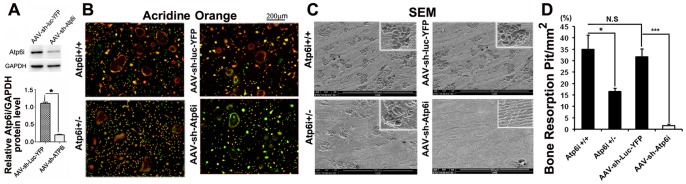
Both knockdown and haploinsufficiency of Atp6i impaired osteoclast-mediated extracellular acidification and bone resorption in vitro.(A) Western blot of Atp6i expression in mouse bone marrow (MBM) stimulated with M-CSF/RANKL for 1 day and transduced with AAV-sh-luc-YFP or AAV-sh-Atp6 and cultured for an additional 4 days. Quantification of western blot analysis demonstrates that AAV-sh-Atp6i treated osteoclasts have significantly reduced expression of Atp6i as compared to the AAV-sh-luc-YFP treatment group. (B) Acridine orange staining of osteoclasts including cells without fusion (<3 nuclei). Osteoclasts from Atp6i+/− mice show weak extracellular acidification (weak orange coloration) compared to osteoclasts from Atp6i+/+ mice. Osteoclasts transduced with AAV-sh-Atp6i have even less extracellular acidification (green coloration) compared to osteoclasts transduced with AAV-sh-luc-YFP. (C) Bone resorption pits were visualized by scanning electron microscopy (SEM). AAV-sh-Atp6i treatment and Atp6i knockdown greatly reduced the functions of osteoclasts. (D) Quantification of SEM bone pits shows bone resorption in the bone slices is significantly lower in the AAV-sh-Atp6i treatment group as compared to the AAV-sh-luc-YFP treatment group (n = 3 in each group). *** indicates P<0.001.